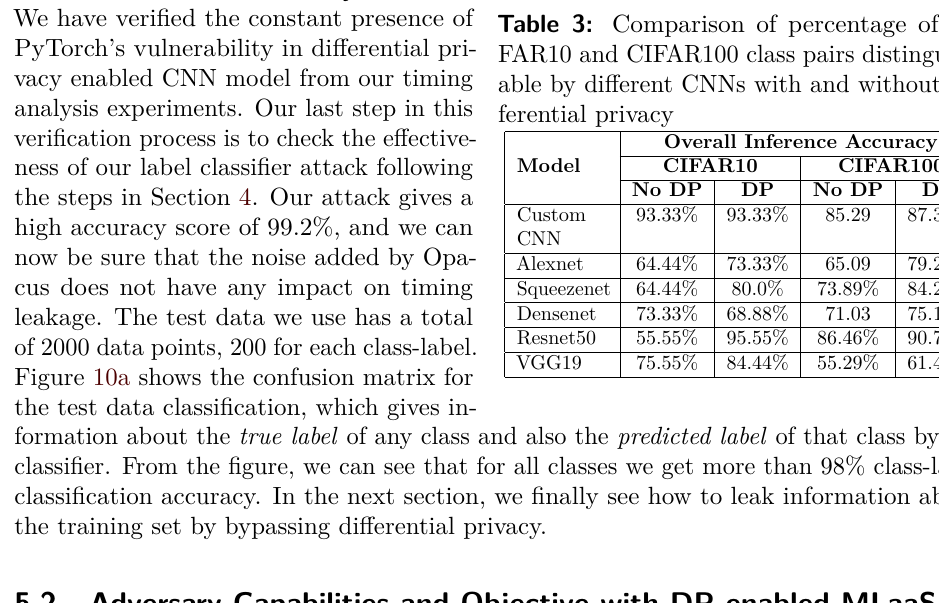
distinguish 43(95 . 5%) and 40(88 . 8%) class-pairs respectively. Hence, this again confirms